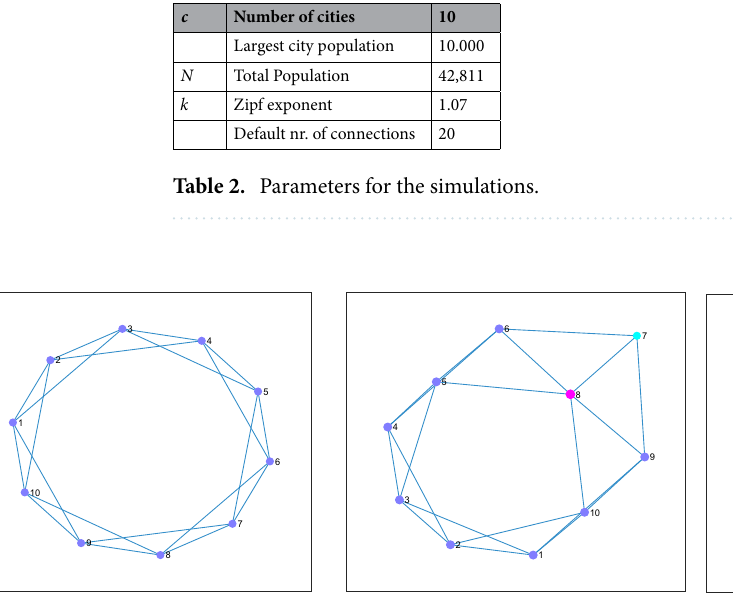
Figure 2. Spatial distributions of the three scenarios. Each scenario figure shows the sizes of the cities, by circles, and by the color bar on the right. Lines present the connections between cities that the agents may use for